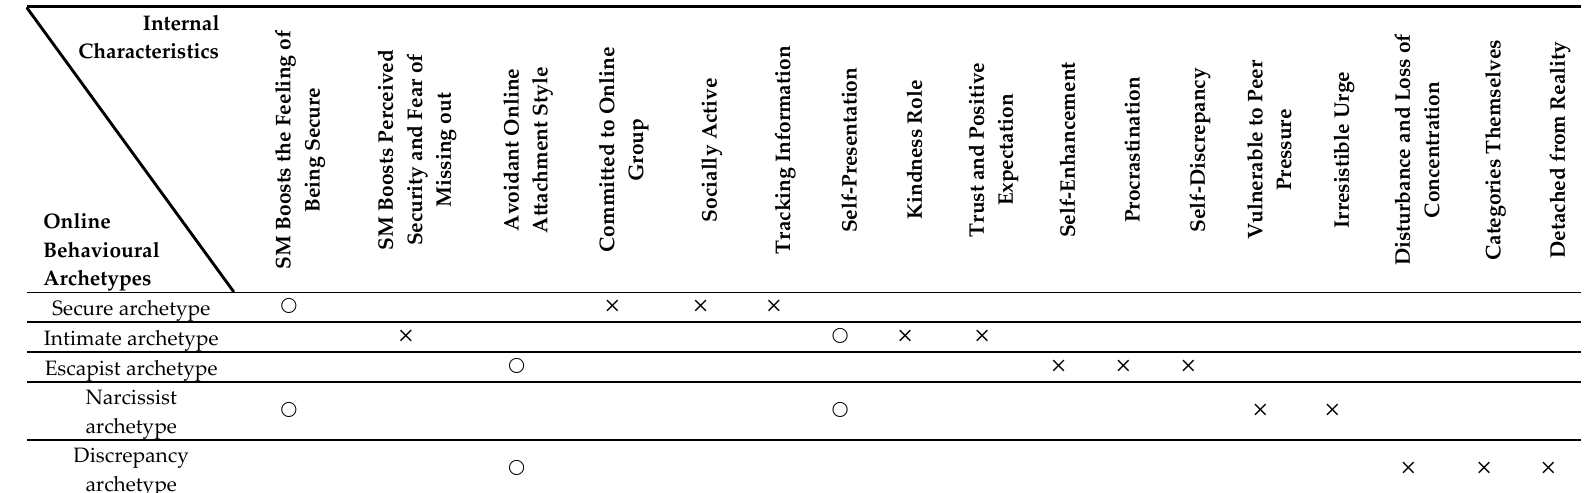
Table 4. Key internal characteristic di ff erences for the five behavioural archetypes.